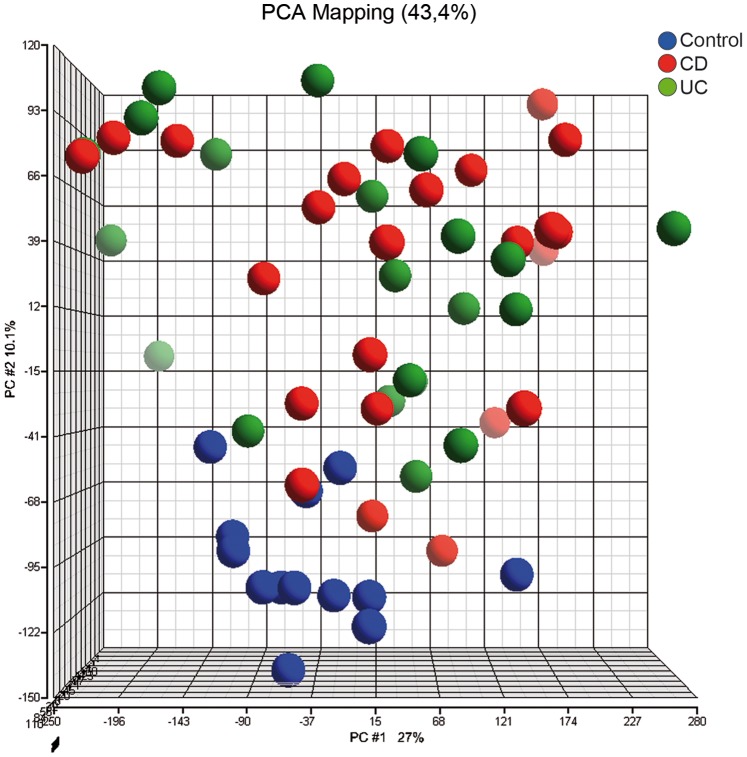
Gene expression profiles of quiescent pediatric IBD patients.Global gene expression profiles of peripheral blood leukocytes were analysed using principal components analysis (PCA). Samples with higher similarity between gene expression profiles cluster more strongly together in the PCA space. Crohn’s disease (red) and ulcerative colitis (green) patients with quiescent disease are not different from each other and form a heterogeneous cluster that is distinct from controls (blue).